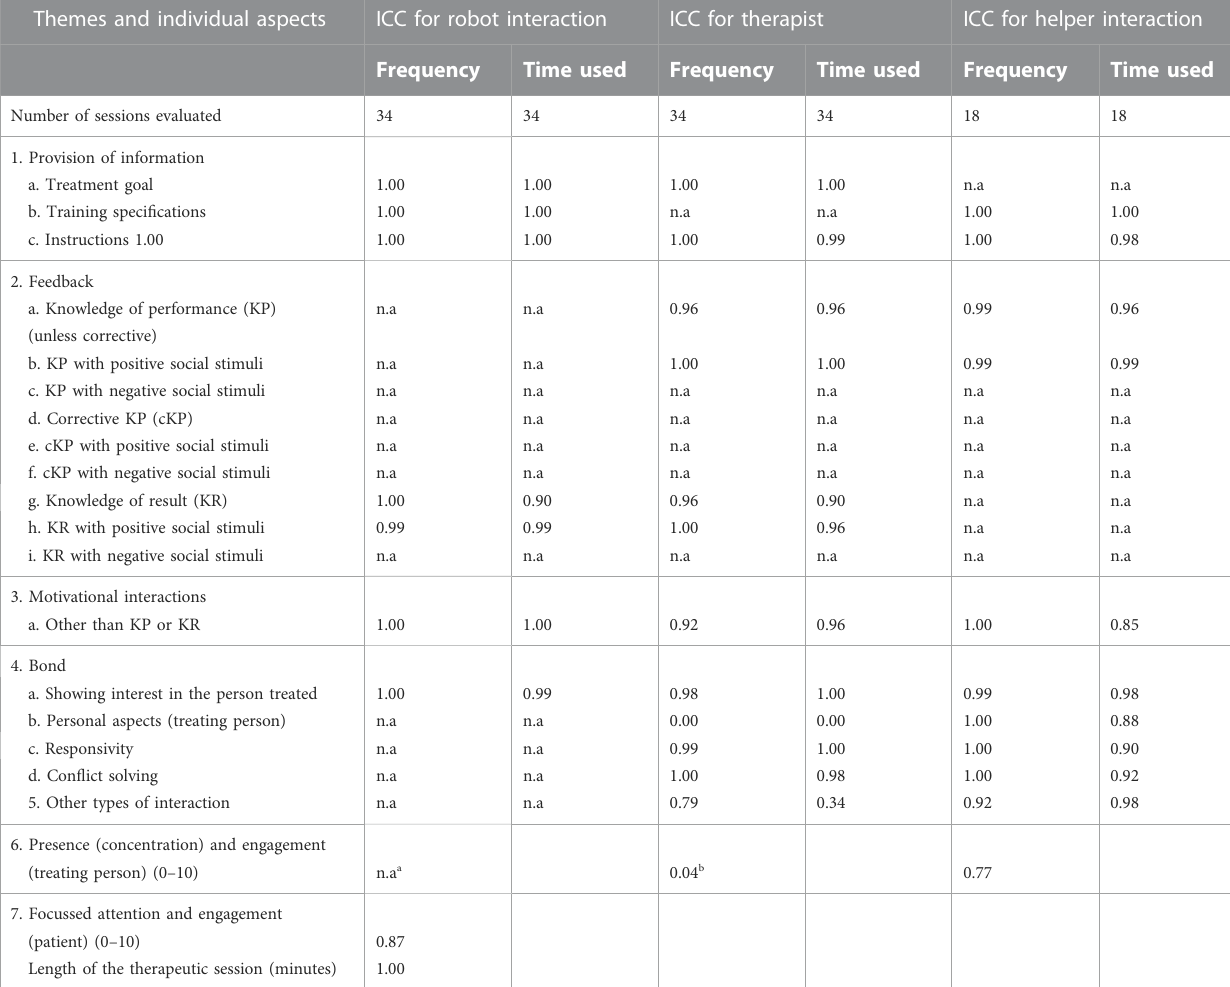
TABLE 3 THER-I-ACT observations: The inter-rater reliability for individual categories (rater r = 2, participants n = 17, and sessions per participants s = 2). Themes and individual